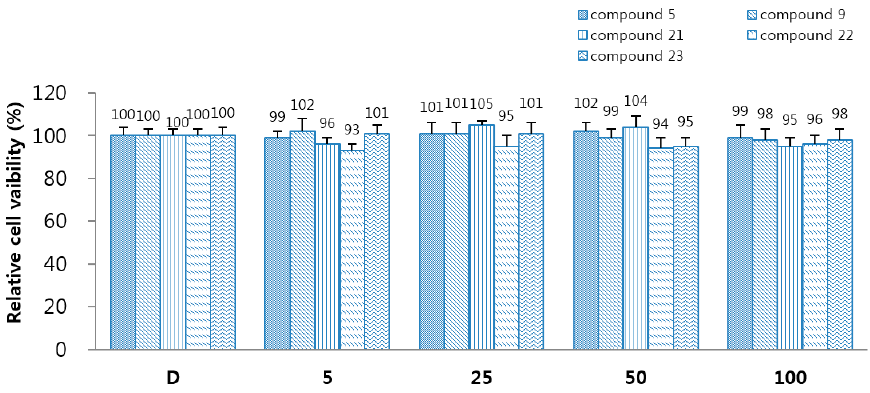
Figure 3. Effects of 5 , 9 , and 21 – 23 on cellular viability were determined by MTT assay. The data represent the mean ± SEM of three independent experiments performed in triplicate. D: 0.2% DMSO is the